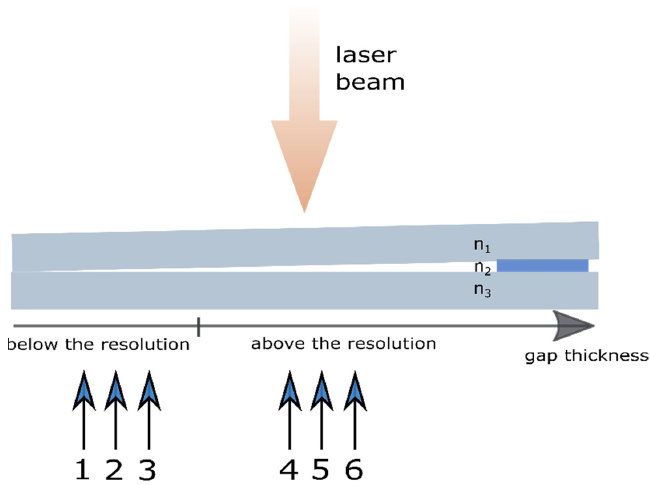
Figure 13. The theory and proof of concept of the wedge-cell measurement. The measurements were made at measurement points (P1–P6), where P1 is the thinnest point and P6 is the thickest point. According to the mathematical model of the layer, n 1 and n 3 are a refractive index of soda-lime-silica glass, and n 2 is a refractive index of air.